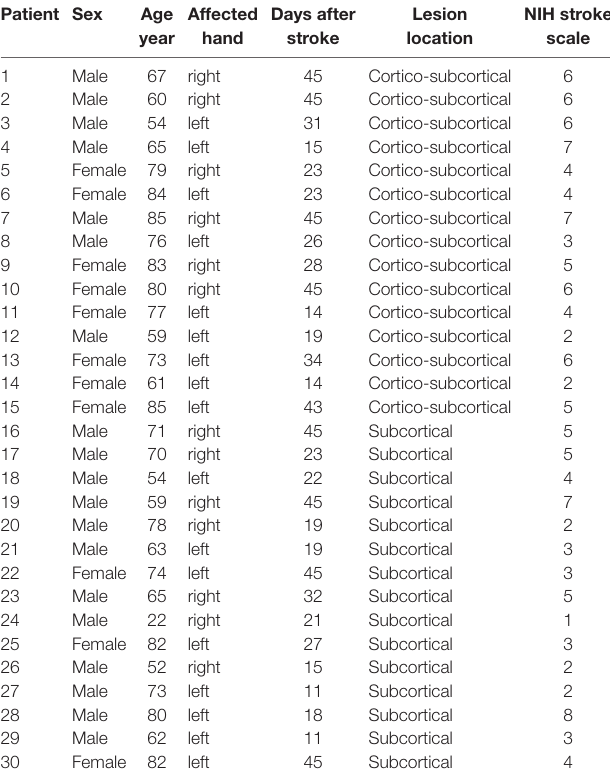
( Table 1 ). Ten neurologically intact age-matched right-handed subjects (M/F: 4/6; mean age ± SD: 62.0 ± 10.3 years)